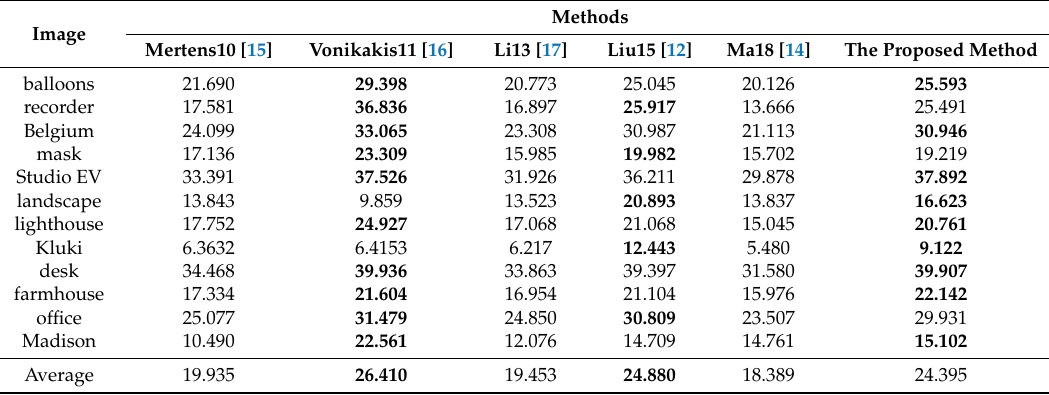
Table 3. Performance of different methods on the 12 image sequences, using the distortion identification- based image verity and integrity evaluation (DIIVINE) [39]. Top two values are shown in bold.